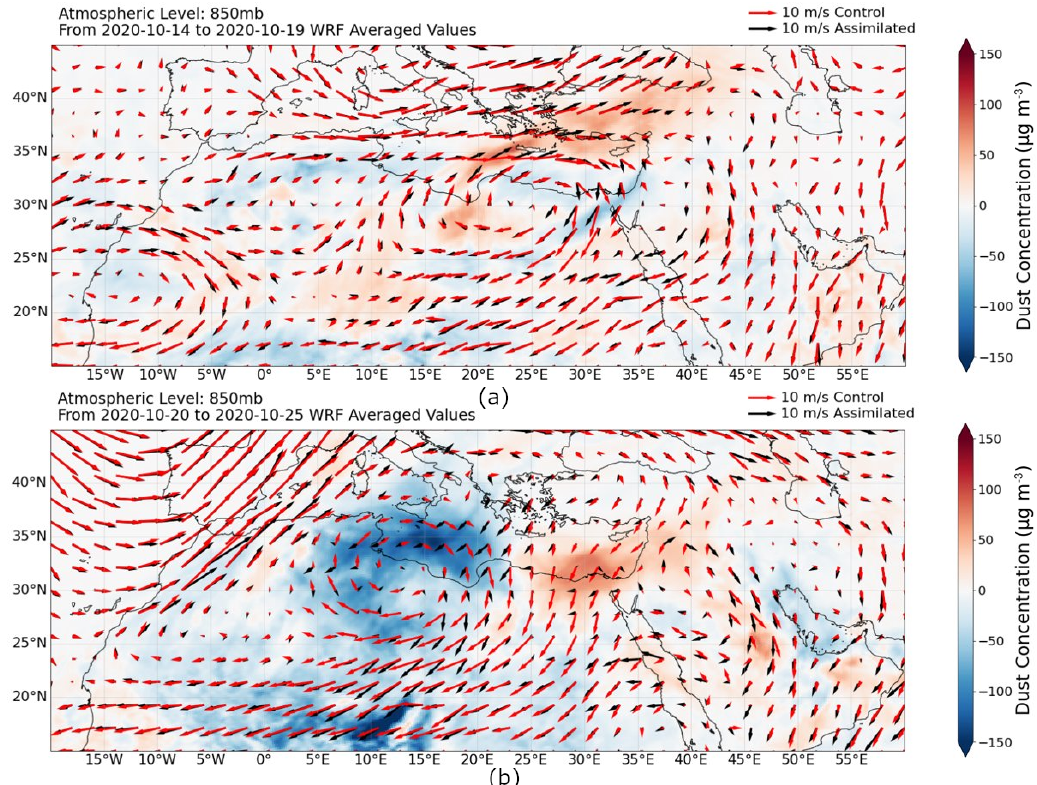
Figure 4. Averaged dust concentration differences (assimilated–control) and wind fields at the atmospheric level of 850mbar for the time- averaged periods, 14–19 October (a) and 20–25 October (b) , where the red arrows represent the control wind vectors and the black arrows the assimilated